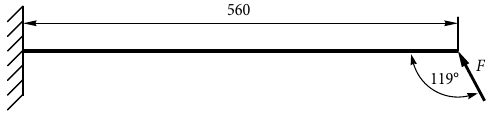
Fig. 9. Simplified loading scheme of A-pillar